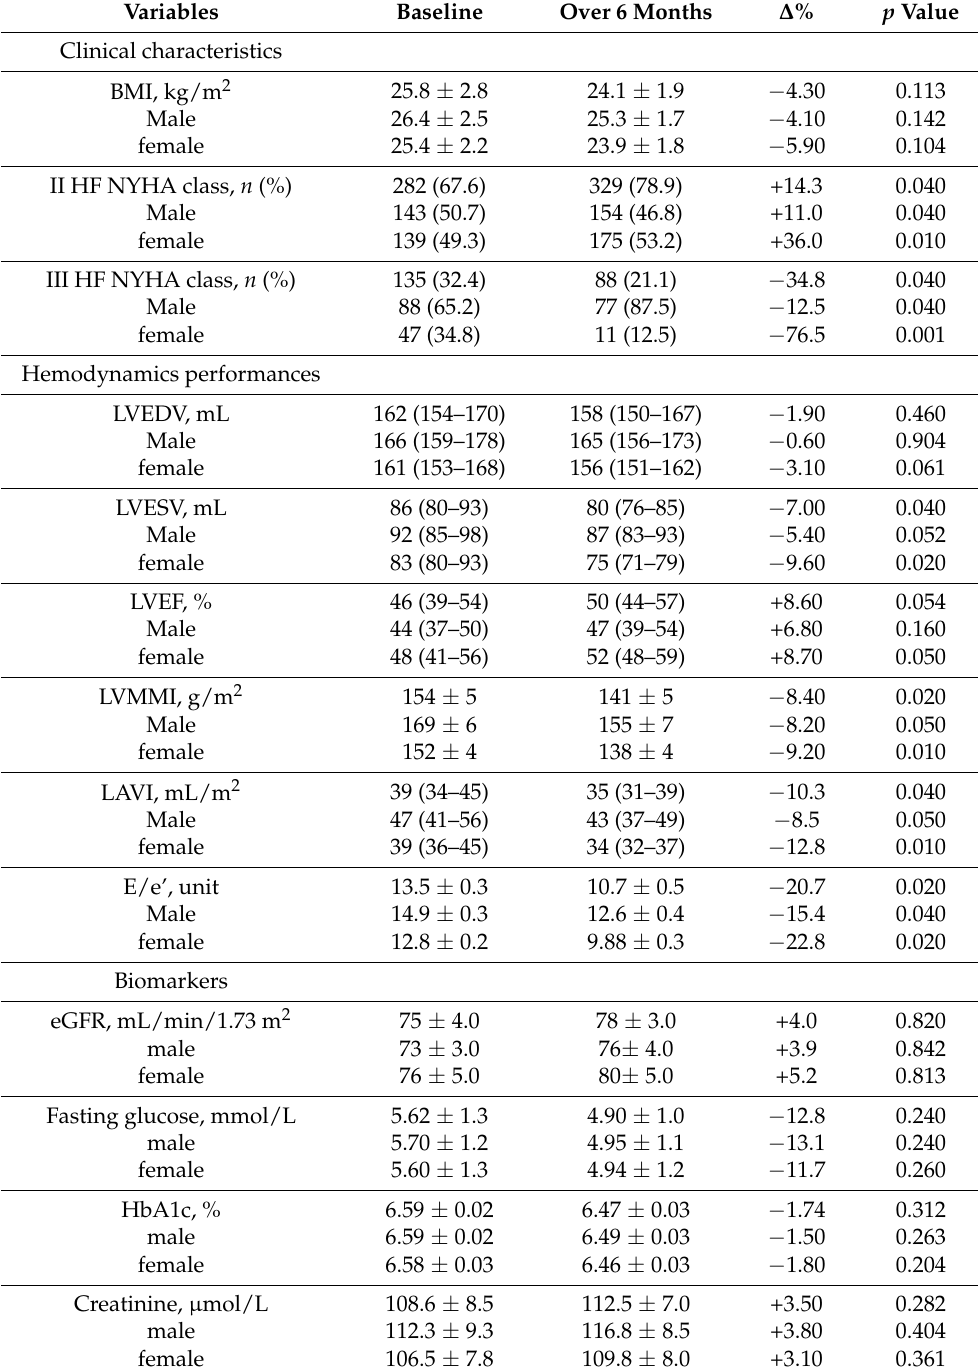
Table 2. Comparisons between baseline and 6-month variables after the administration of SGLT2 inhibitor dapagliflozin in males and